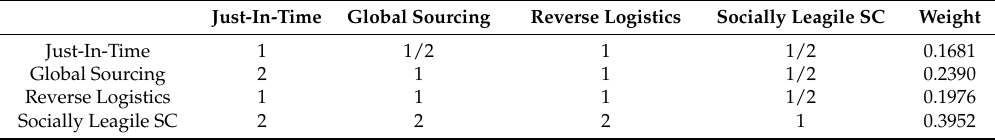
Table A8. Pairwise Comparison of Alternative w.r.t. sub-criterion Operating Expenditure.